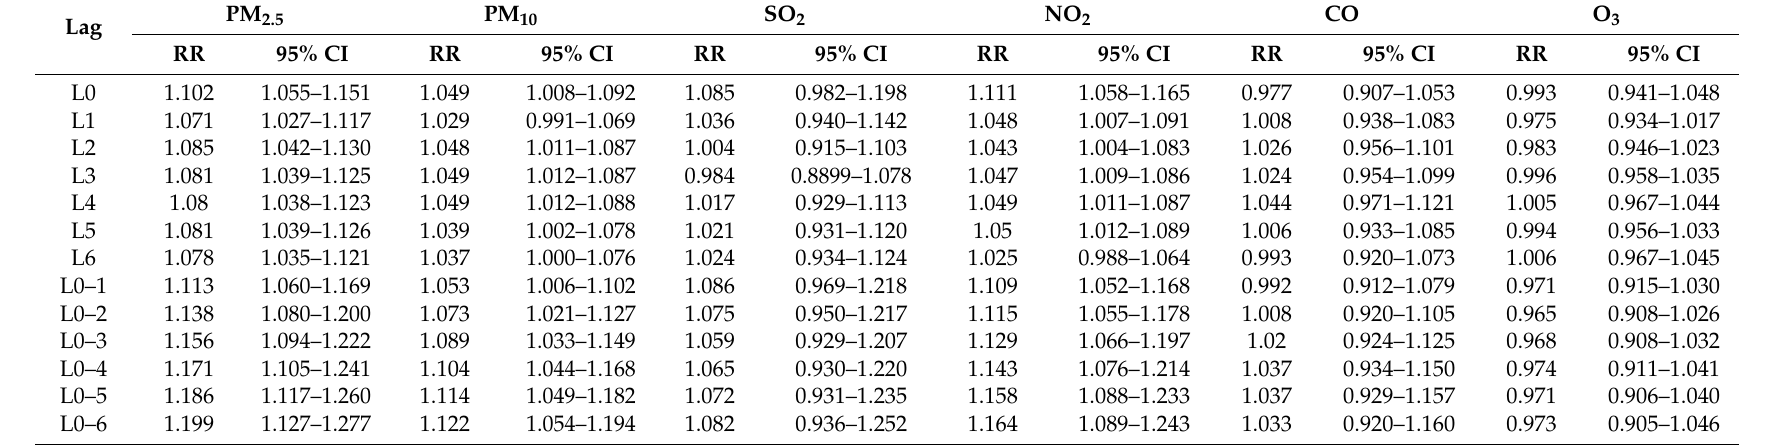
Table 4. Associations between each 1-SD increase of air pollution with different lag periods and allergic rhinitis